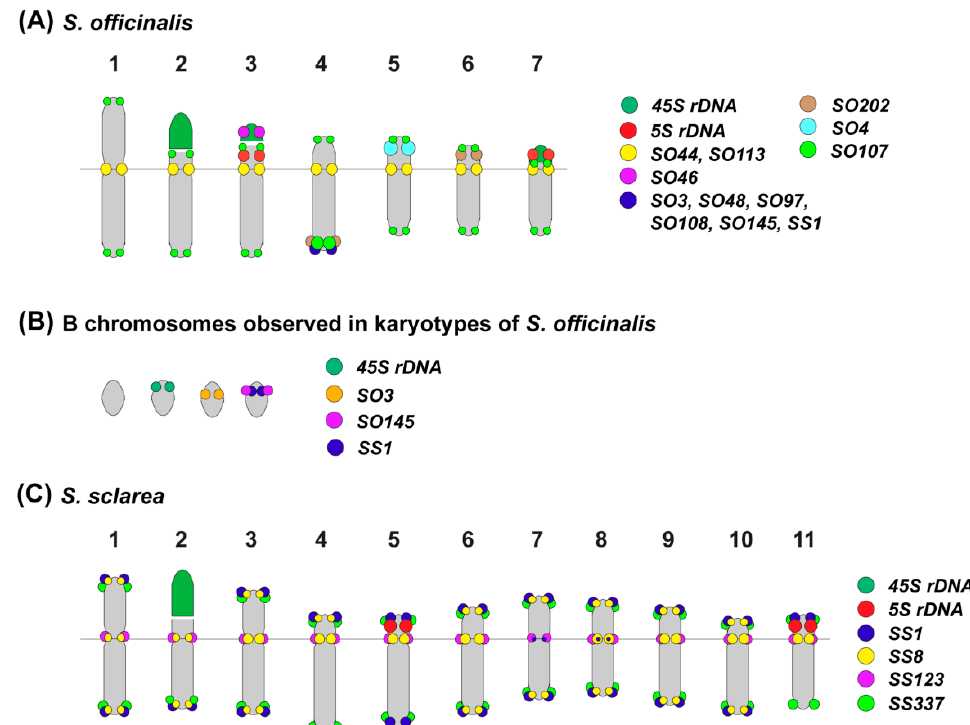
Figure 7. Chromosome schematic representation of the Salvia species karyotypes and revealed B chromosomes ( A – C ), showing the positions of the oligonucleotide-based probes. Probe colors are shown on the right.